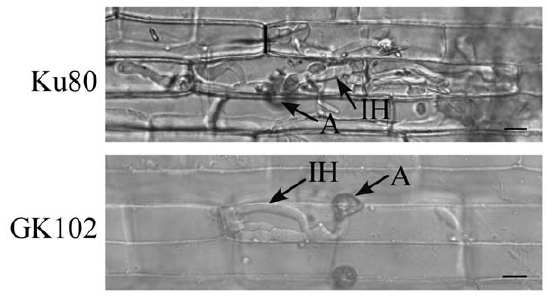
Figure 5. Penetration assays with the Mosfl1 mutant. Rice leaf sheaths inoculated with conidia from Ku80 and Mosfl1 mutant GK102 were examined 48 hpi. The mutant was restricted in invasive growth compared with the wild type. A, appressorium; IH, invasive hyphae. Bar=10 m m.